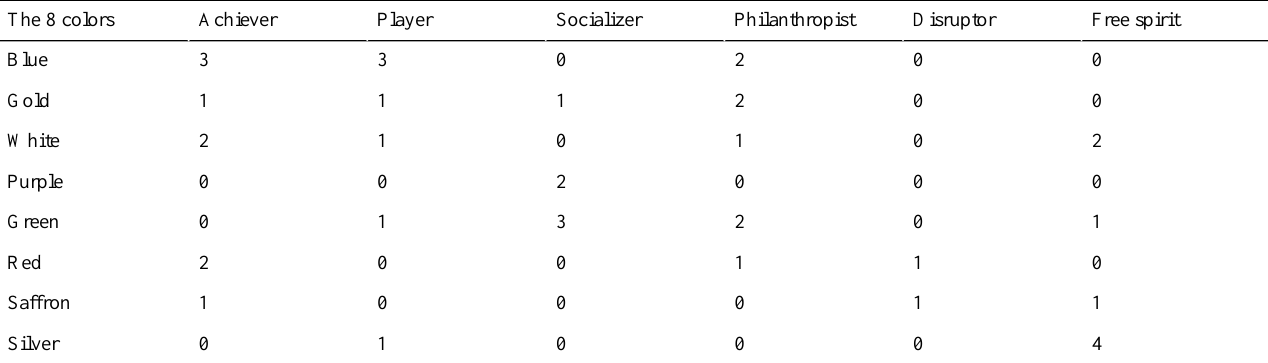
Table 4. Distribution of the combination of player or exerciser type (N=40).